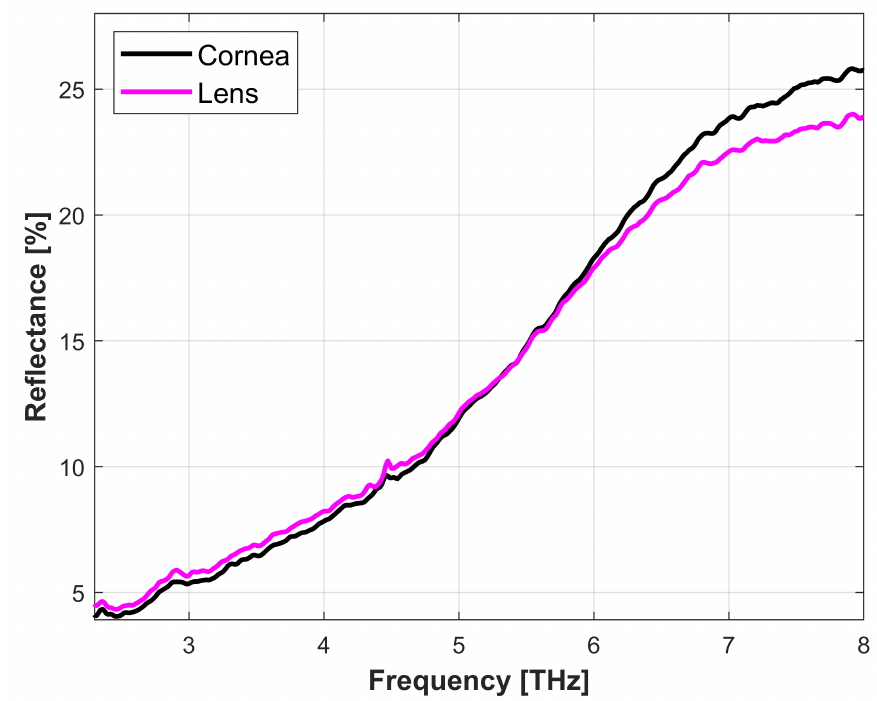
Figure 6. The reflectance spectra of porcine cornea and lens in the range of 2.4 to 8